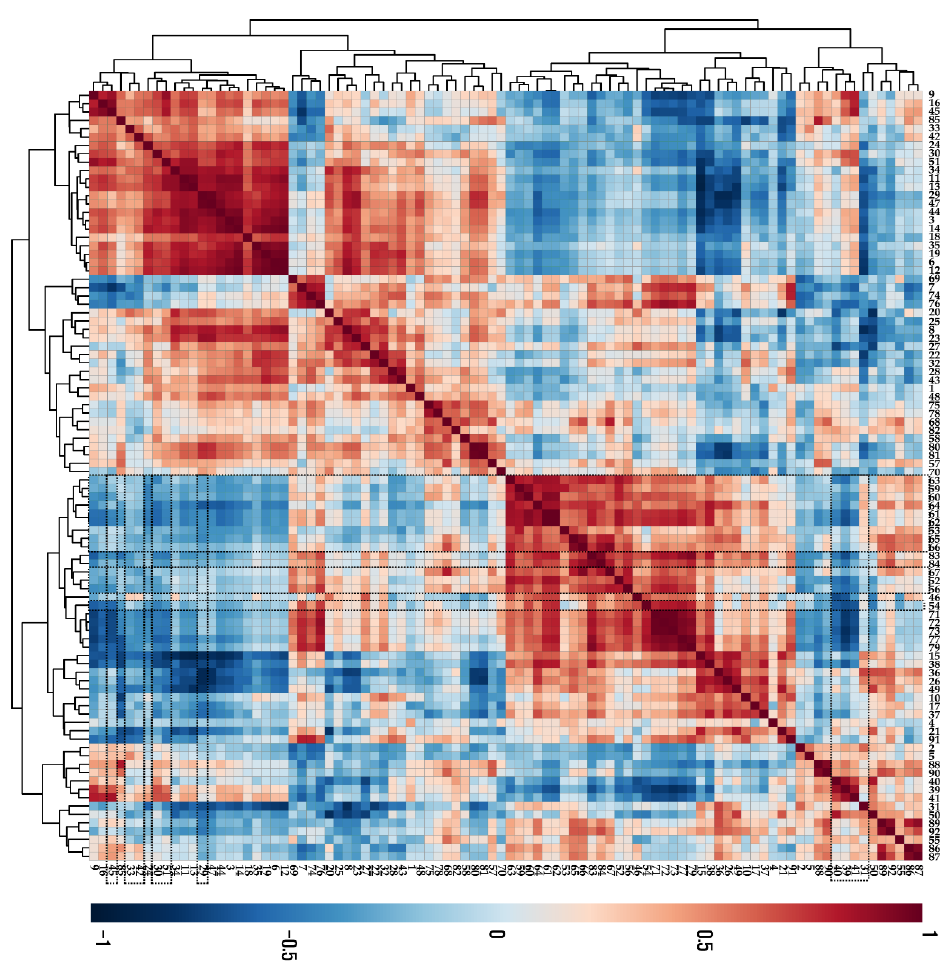
Figure 3. Correlation matrix of metabolites present in UVB-irradiated purple kohlrabi sprouts. Con- trol, purple kohlrabi sprouts grown without UVB treatment for 0 h, 6 h, 12 h, 24 h, and 48 h; test, purple kohlrabi sprouts irradiated with UVB radiation for 6 h, 12 h, 24 h, and 48 h. Number: 1, Pyruvic acid; 2, Lactic acid; 3, Alanine; 4, Oxalic acid; 5, Glycolic acid; 6, Valine; 7, Urea; 8, Ethanolamine; 9, Phosphoric acid; 10, Glycerol; 11, Leucine; 12, Isoleucine; 13, Proline; 14, Glycine; 15, Succinic acid; 16, Glyceric acid; 17, Fumaric acid; 18, Serine; 19, Threonine; 20, β -Alanine; 21, Malic acid; 22, Aspartic acid; 23, Methionine; 24, Pyroglutamic acid; 25, 4-Aminobutyric acid; 26, Threonic acid; 27, Cysteine; 28,